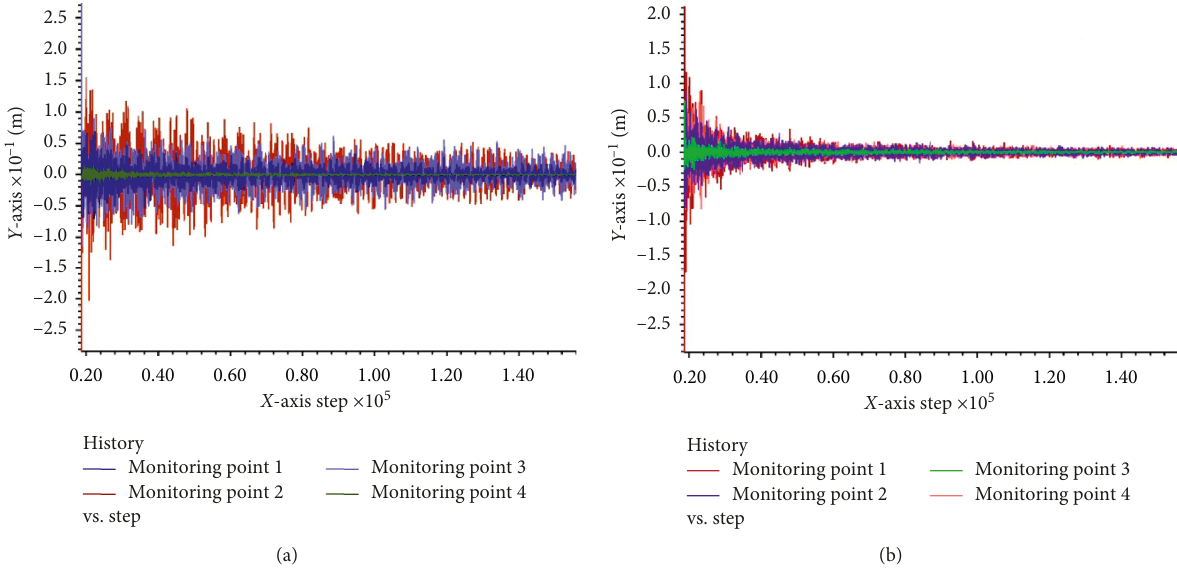
Figure 17: Velocity response diagram for ten dynamic loads. (a) X -directional deformation velocity and (b) Z -directional deformation velocity.